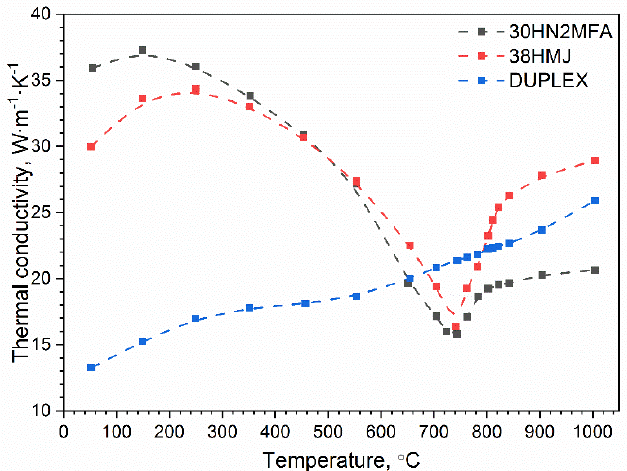
Figure 3. Thermal conductivity of selected barrel steels: 30HN2MFA, 38HMJ, DUPLEX [12].